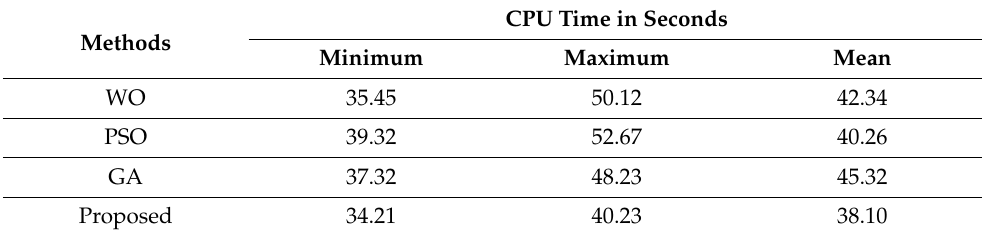
Table 4. Comparative results of CPU time in